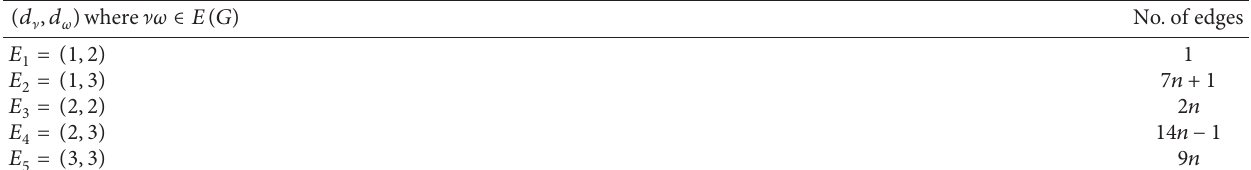
Table 1: The edge partition of the molecular graph of guar gum based on degrees of the end vertices of each edge. ( d , d ) where ] ω ∈ E ( G ] ω